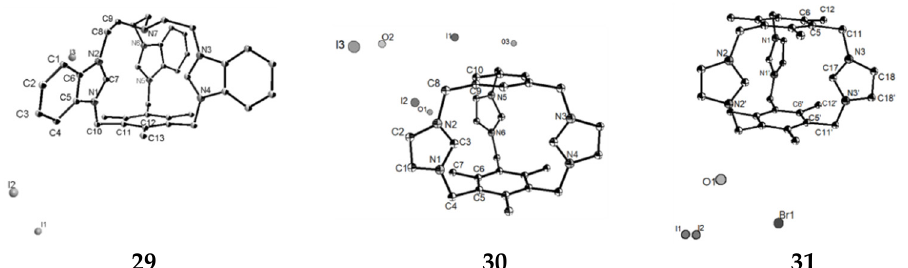
Figure 17. ORTEP drawings of cages 29 , 30 and 31 (the probability of thermal ellipsoid is 50%).